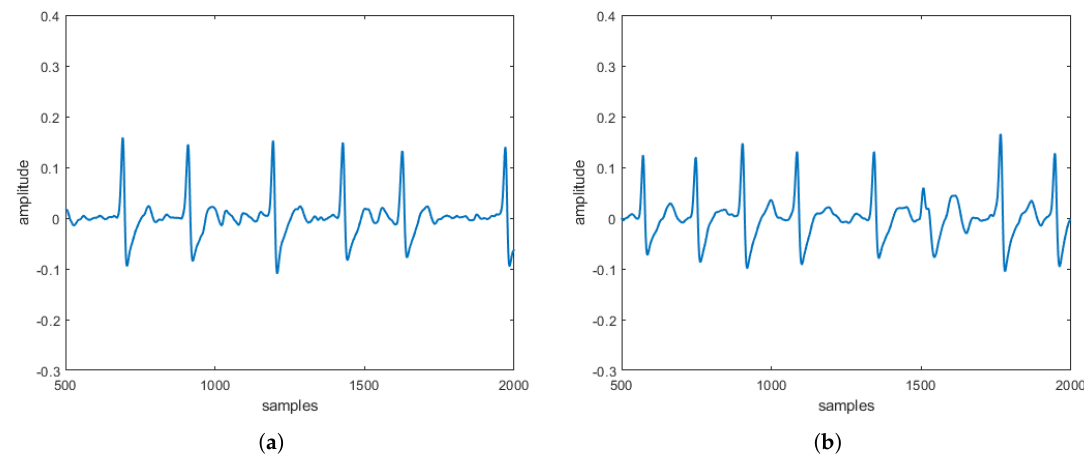
Figure 6. Case (a) of the proposed methodology: ( a ) atrial fibrillation and ( b ) typical ECG with atrial fibrillation.